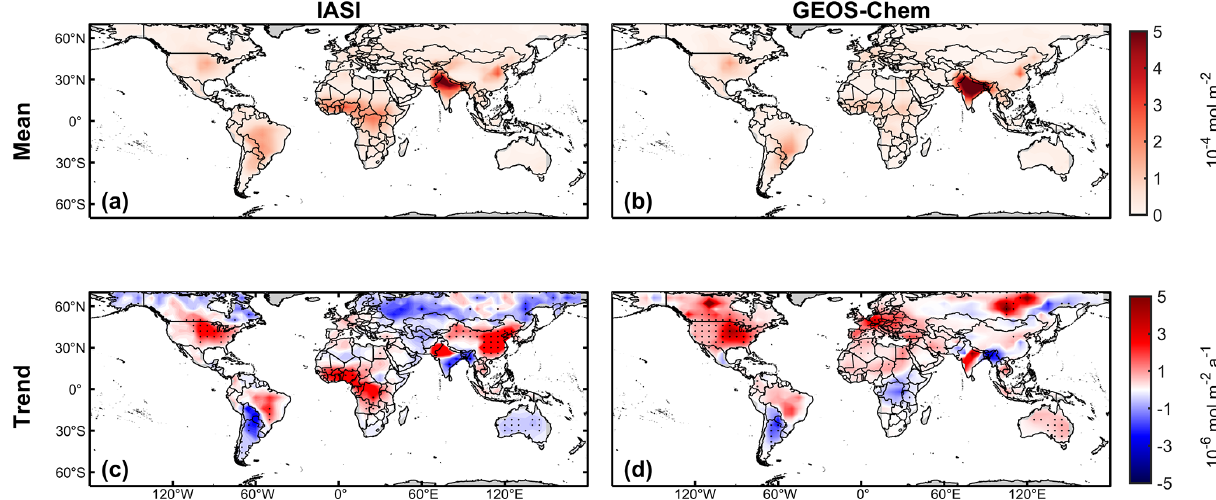
Figure 1. Spatial distribution of (a, c) IASI and (b, d) GEOS-Chem NH 3 column concentrations. (a, b) Mean and (c, d) linear trends within the 70 ◦ N–70 ◦ S band during 2008–2018. The dots in panels (c) and (d) indicate that linear trends are significant at the 95% confidence level. Linear trends are computed from the time series of annual